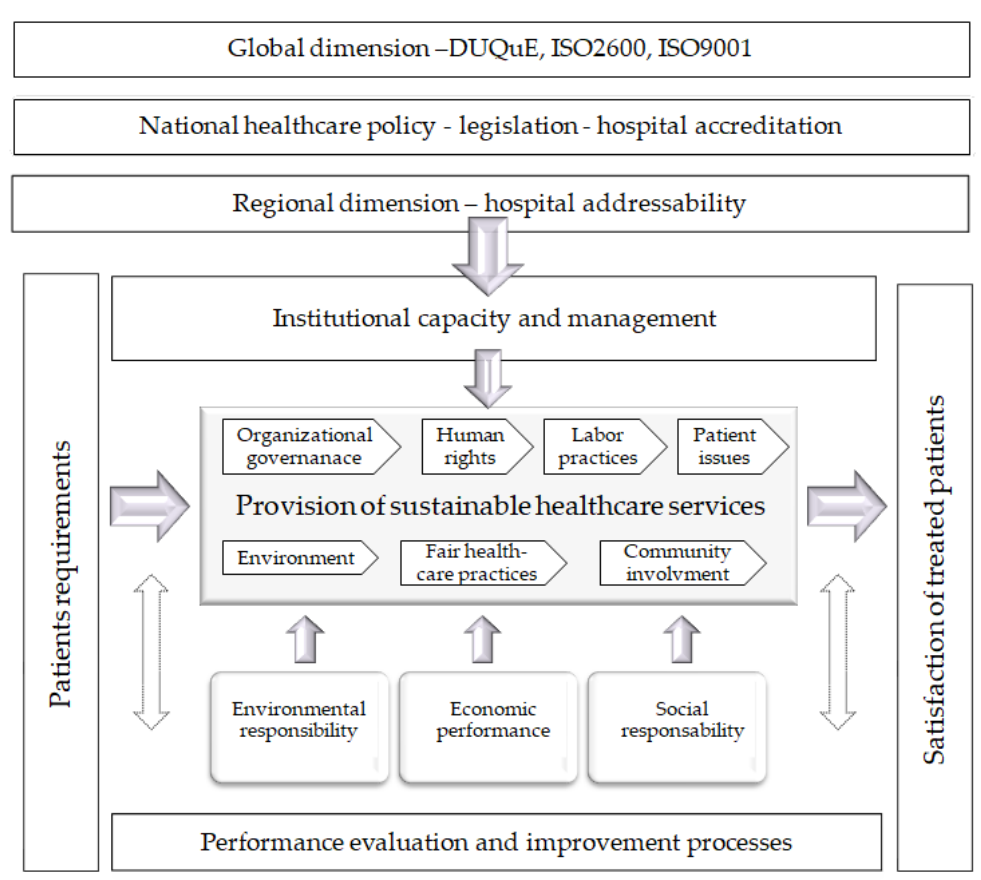
Figure 1. Conceptual model of the Health-Sustainability reference framework.